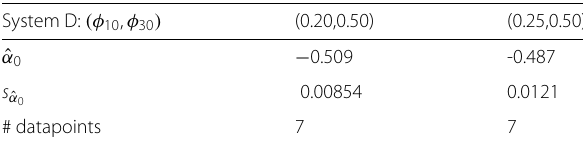
Table 3 Unbiased estimators of α 0 and their standard error for the relationship T real ∼ (cid:14) α 0 describing the dependence of the realistic time interval of System D on the parameter (cid:14) for two different initial